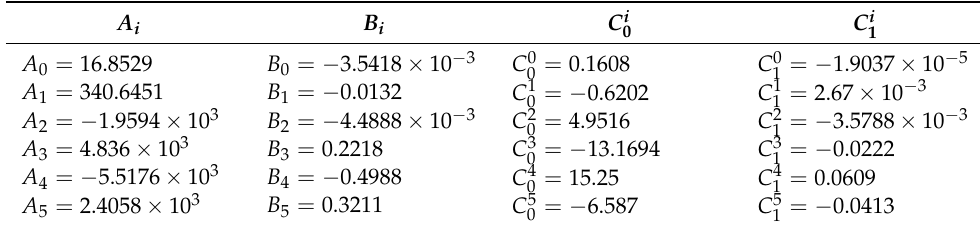
Table 6. Parameter values of the PTM flow law for the P20